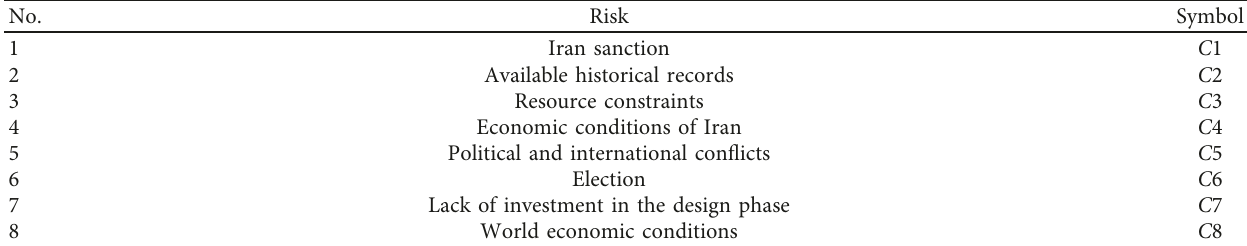
Table 5: Set of project financing risks.